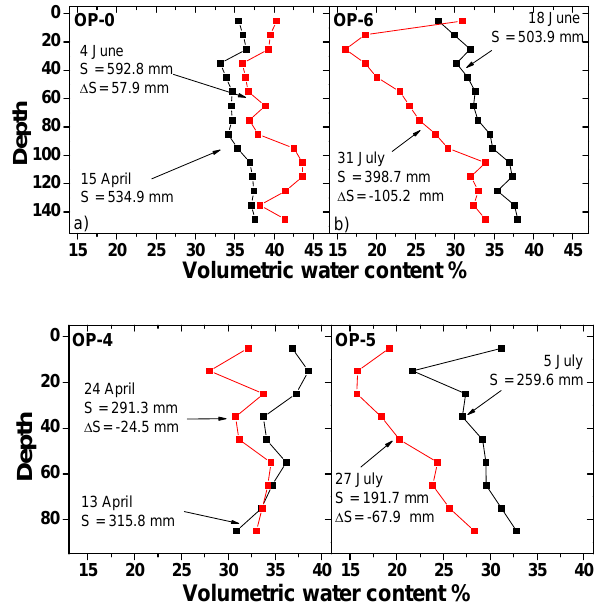
Figure 8. Vertical soil water profiles and change in water storage over four observation periods (OPs) at winter wheat stands at EC1 in 2013. The upper row shows the results of the soil sample campaigns. The soil water contents measured with capacitance soil moisture probes (SM1, Adcon Telemetry, Austria) are shown in the lower row.